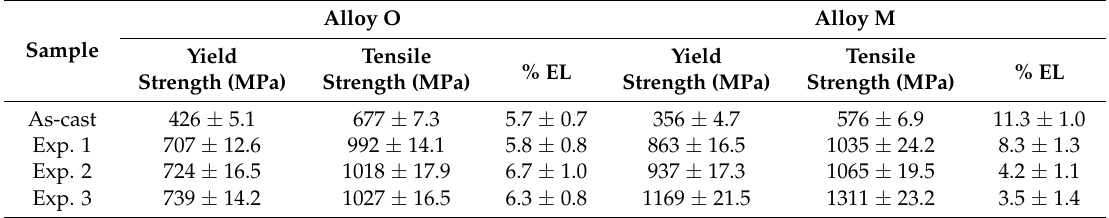
Table 4. Tensile test results of the as-cast and austempered samples as the average of three tests for each.